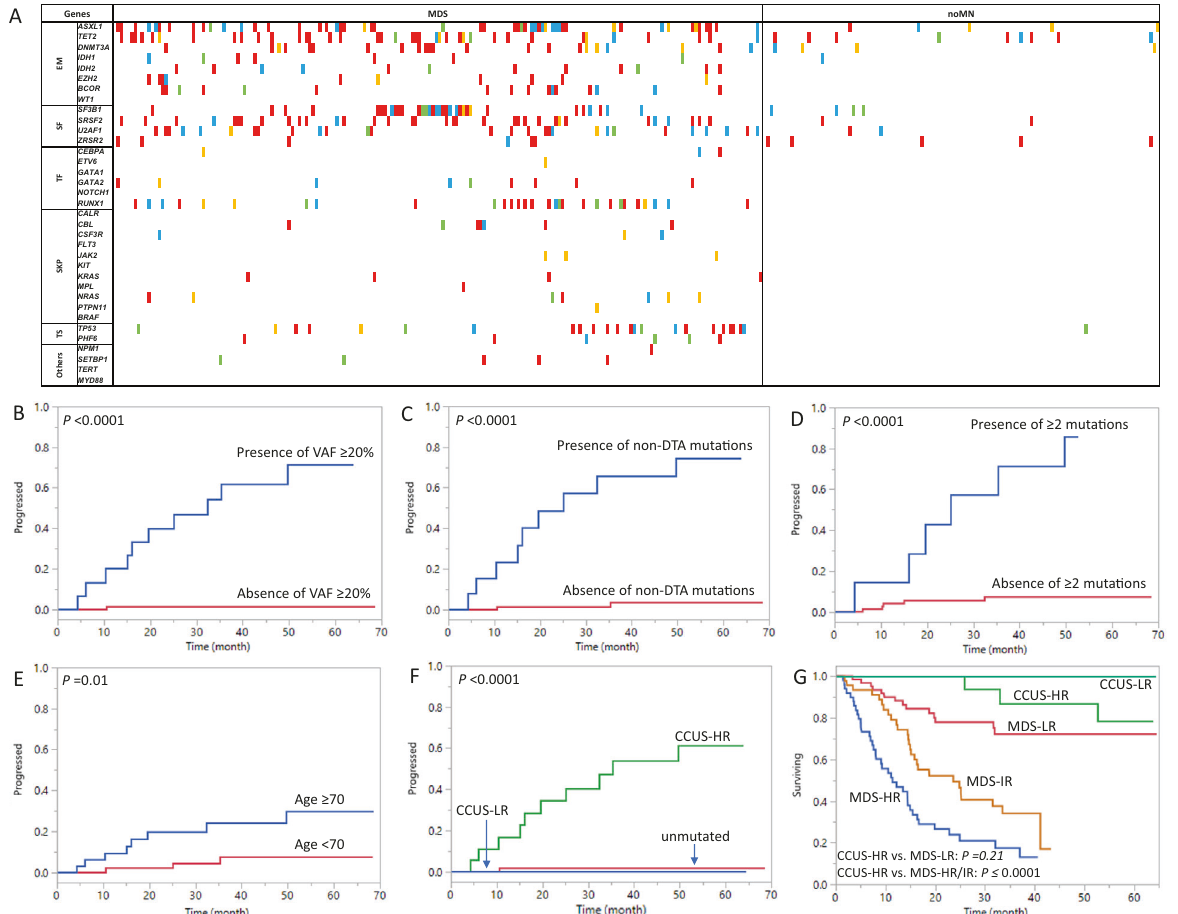
Fig. 1 Mutational landscape of the study cohort and Kaplan-Meier analysis in the noMN patients. A Mutational landscape of the 190 MDS and 116 noMN patients. Mutational VAF is color coded: green, <10%; orange: 10 – 19.9%; blue: 20 – 29.9%; red, ≥ 30%. If multiple mutations are present in a case, the highest VAF is shown. In MDS, mutations occurred most frequently in ASXL1, TET2, SRSF2, SF3B1, RUNX1, U2AF1, TP53 , and DNMT3A , all involving ≥ 10% of MDS cases. Less frequent mutations were seen in BCOR, IDH2, EZH2, GATA2, CBL, IDH1, NRAS, PHF6, ZRSR2, SETBP1, CEBPA, JAK2, KRAS, ETV6, MPL, NPM1 , and PTPN11 , in descending order of frequency (8.4 – 0.5%). In noMN, mutations occurred in TET2 (6.9%), ASXL, ZRSR2 (each 4.3%), DNMT3A, SF3B1 (each 3.4%), SRSF2, U2AF1 (each 1.7%), and TP53 and IDH1 (each 0.9%). B – G In the 116 noMN patients, the median time to MN progression was 32.4 months in patients with VAF ≥ 20% ( n = 16) vs. not reached in patients without VAF ≥ 20% (unmutated or mutational VAF < 20%, n = 100), log rank p < 0.0001 ( B ); 25.2 months in patients with non-DTA mutations ( n = 14) vs. not reached in patients without a non-DTA mutation (unmutated or with DTA-only mutations, n = 102), log rank p < 0.0001 ( C ); 25.2 months in patients with ≥ 2 mutations ( n = 7) vs. not reached in patients without ≥ 2 mutations (unmutated or with one mutation, n = 109), log rank p < 0.0001 ( D ); Age ≥ 70 years ( n = 45) was associated with MN progression in comparison to age <70 years ( n = 71), median not reached in both, p = 0.01 ( E ). CCUS with high-risk markers (CCUS-HR, n = 19) showed a median time to progression of 35.2 months vs. not reached in the CCUS low-risk group (CCUS-LR, n = 7) and unmutated noMN group ( n = 90), log rank p < 0.0001 ( F ). The OS of CCUS-HR ( n = 19) was similar to that of low-risk MDS (MDS-LR, n = 72, median not reached in both, log rank p = 0.21) but superior compared to high-risk MDS (MDS-HR, median 11.4 months, n = 57, log rank p < 0.0001) and intermediate-risk MDS (MDS-IR, median 23.6 months, n = 55, log rank p = 0.0001) ( G ). EM epigenetic modi fi ers, SF splicing factors, TF transcription factors, SKP signaling and kinase pathway factors, TS tumor suppressors, MN myeloid neoplasm, VAF variant allele fraction, CCUS clonal hematopoiesis of undetermined signi fi